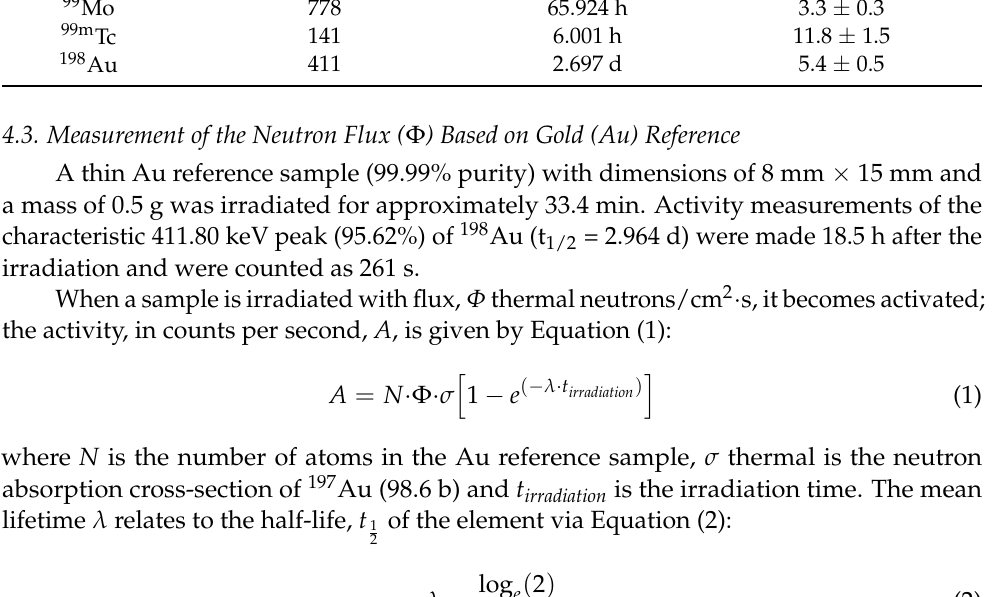
Table 6. Measured isotopes and emission lines of interest with corresponding detector efficiencies. Isotope Energy of Key Line (keV) Half-Life Detector Efficiency (%) 101 Mo 192 14.61 m 307